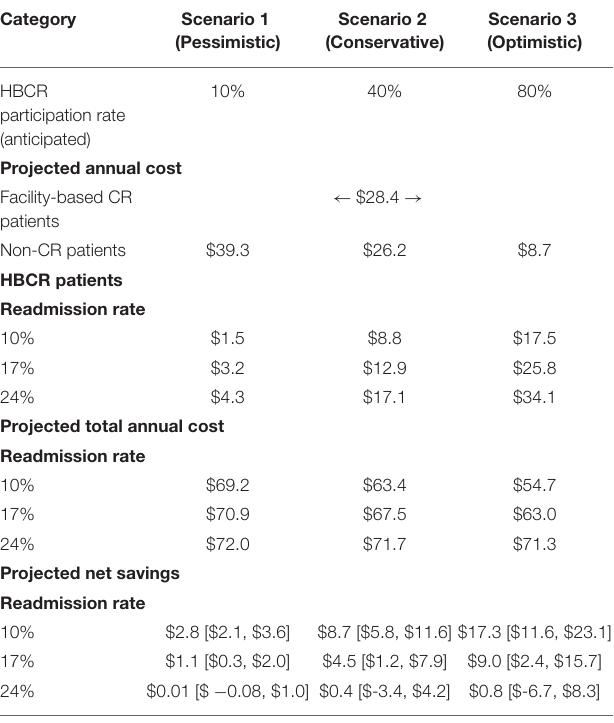
TABLE 2 | Results of economic impact analysis. Category Scenario 1